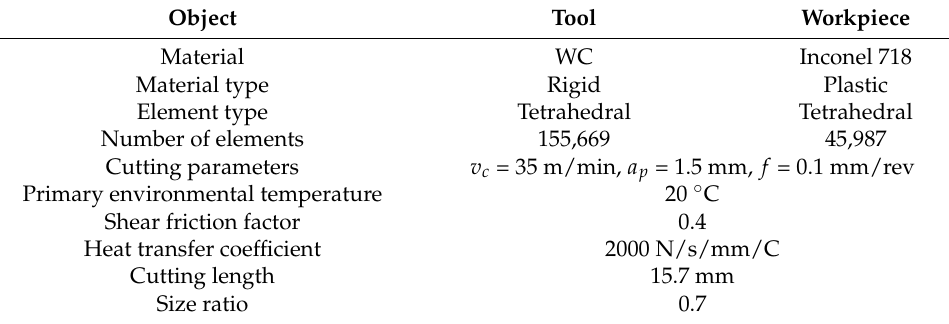
Table 3. Finite-element simulation condition